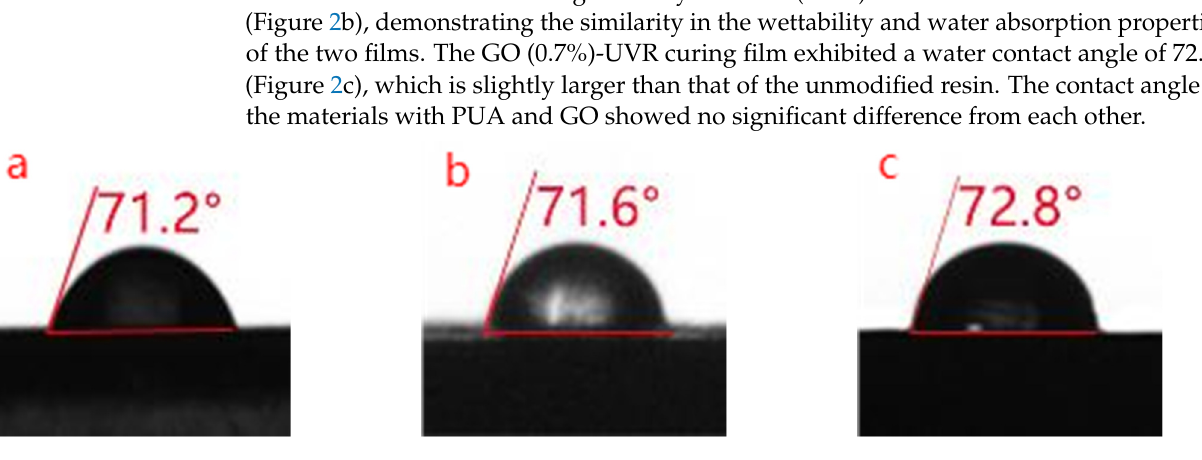
Figure 2. Water contact angles of ( a ) free − radical/cationic hybrid, ( b ) polyurethane acrylates (PUA, 20%) modified, and ( c ) graphene oxide (GO, 0.7%) modified photosensitive resins.